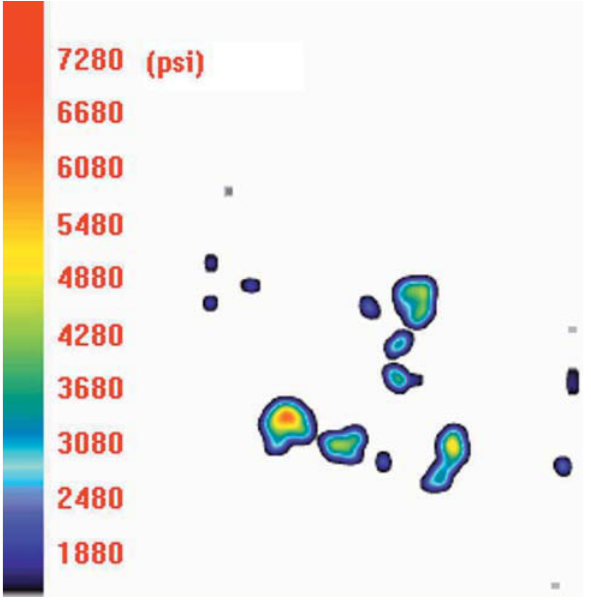
FIGURE 2- Pressure distribution in the premolar occlusal